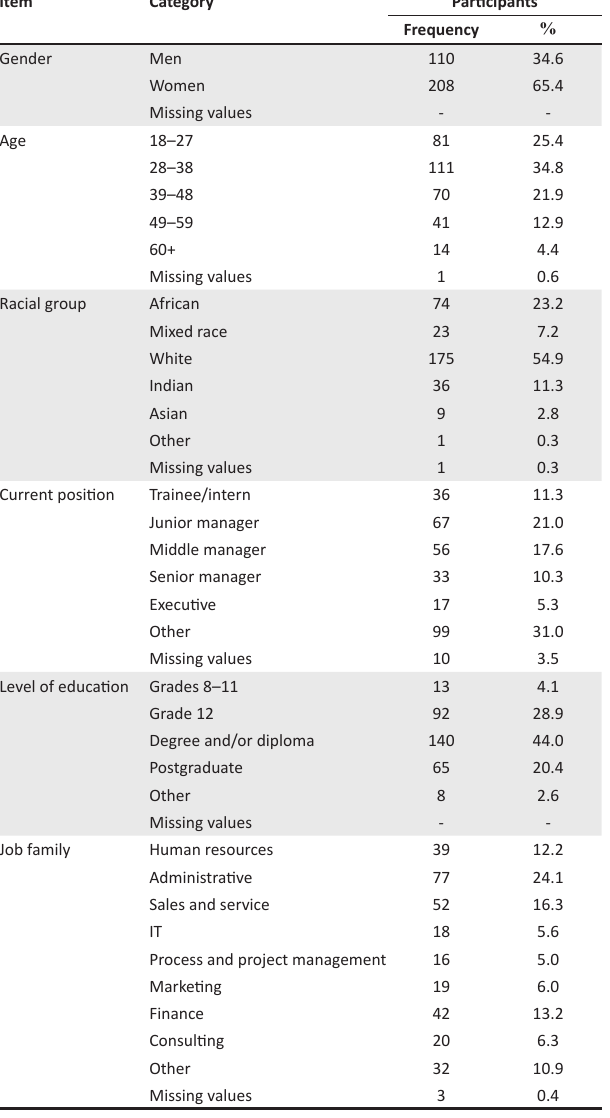
TABLE 1: Demographic and biographical characteristics of participants ( N = 318). Item